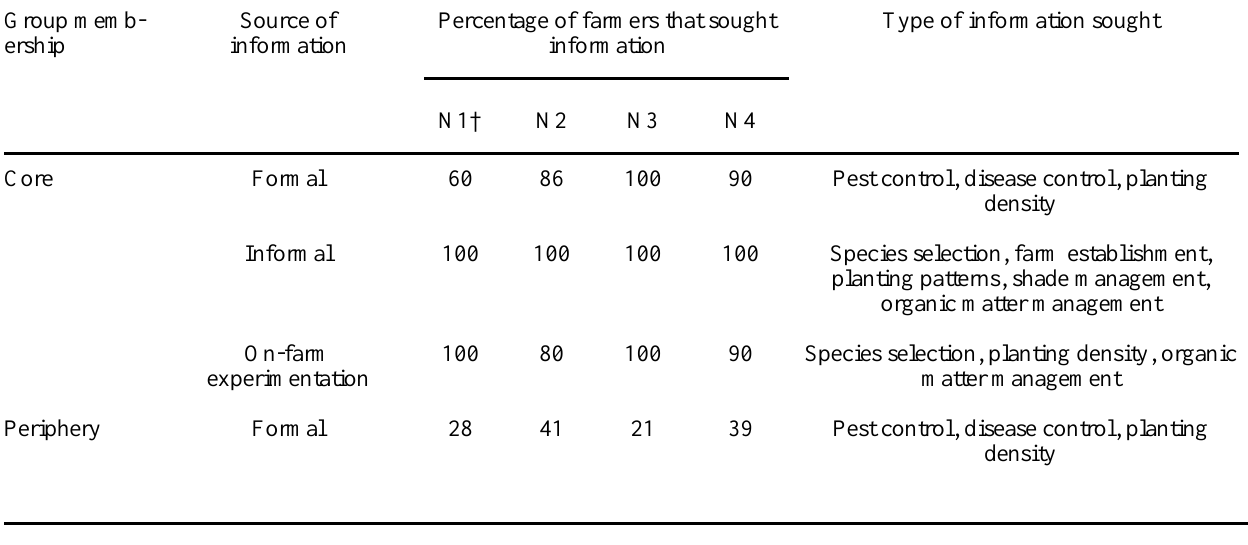
Table 4. Percentages of farmers that sought information from various sources. The most highly mentioned types of information are